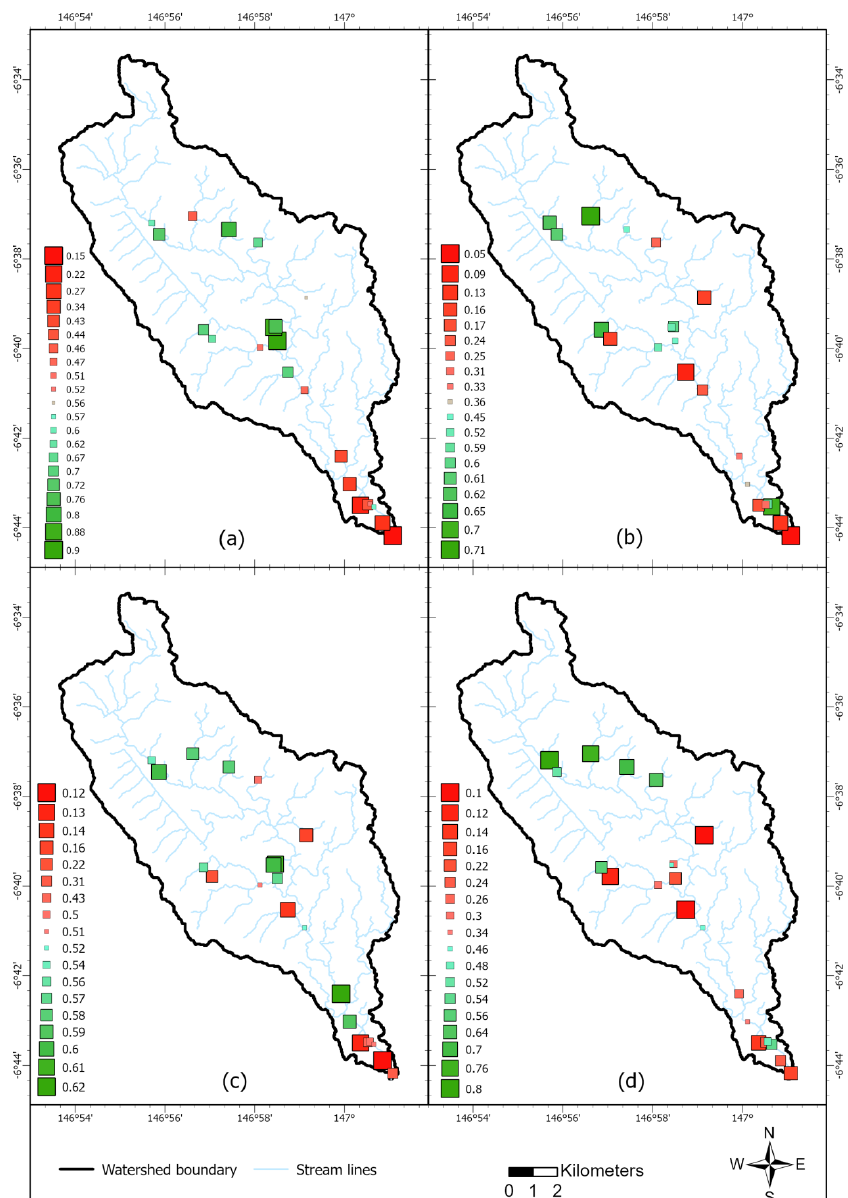
Figure 3. Depiction of spatial distribution ( a ) community crime, ( b ) community pollution, ( c ) commu- nity waterborne disease, and ( d ) household waterborne disease. Colour range is fixed and applied on survey result, from red (lowest score) to green (highest